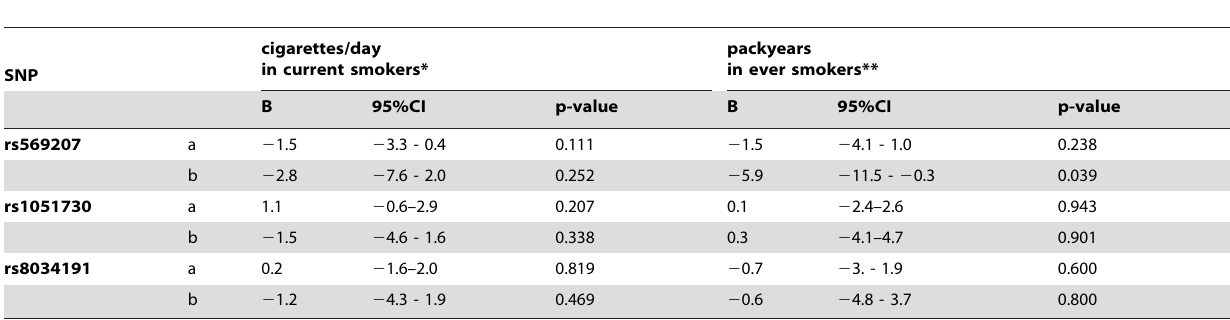
Table 3. SNPs in the nAChR cluster with cigarettes smoked per day in current smokers, and packyears in ever smokers at the last survey.